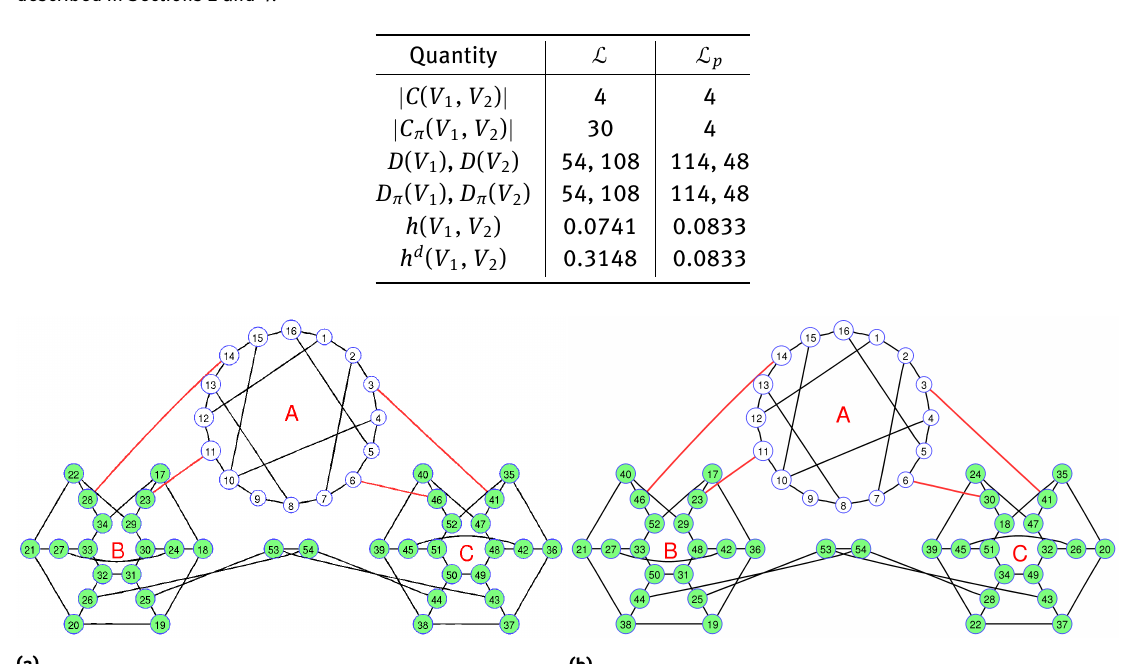
Table 1: Results of spectral bisection using the second eigenvectors of L and L p for the Ellingham-Horton 54 graph. The column headed “ L ” contains evaluations using the partition { V 1 , V 2 } that minimises h ( V γ 1 , V γ 2 ) . The column headed “ L p ” contains evaluations using the partition { V 1 , V 2 } that minimises h d ( V γ 1 , V γ 2 ) . The partitions V 1 , V 2 are obtained using the method described in Sections 2 and 4.